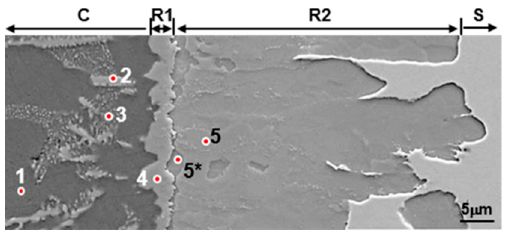
Figure 2. Scanning electron microscope (SEM) micrographs of specimens that were hot-dipped at 690 °C for 120 s. Table 1. Energy-dispersive spectroscopy (EDS) analysis results and expected phases in the area indicated by 1–5 in Figure 2. Chemical Composition (at. %) Expected Phases No. Al Ni